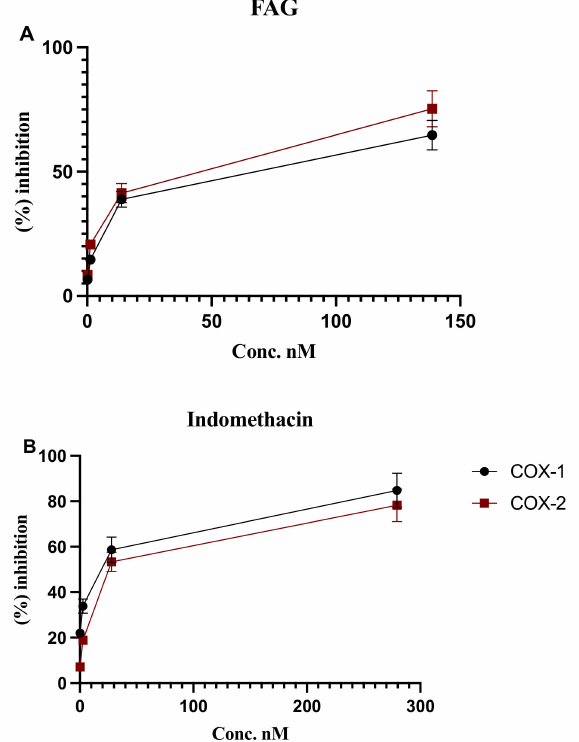
Figure 4. The in vitro inhibitory effect of ( A ) FAG on COX-1 and COX-2 enzymes activity at the concentrations of 0.13, 1.3, 13.8, and 138.7 nM. ( B ) Indomethacin was used as a positive control at the concentrations of 0.27, 2.7, 27.9, and 279.4 nM. Bars represent mean ± SD ( n =